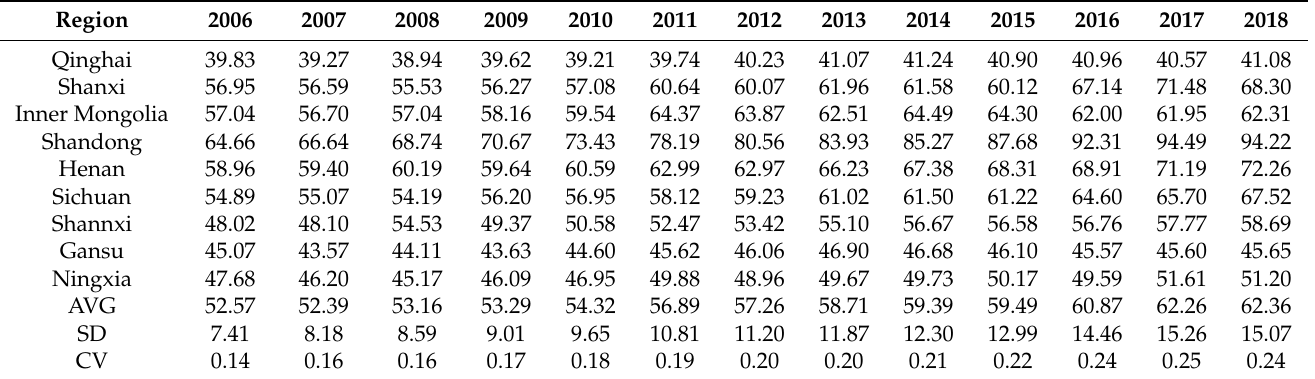
Table 2. Comprehensive scores of the co-benefits of carbon reduction and air pollution control in the YRB.